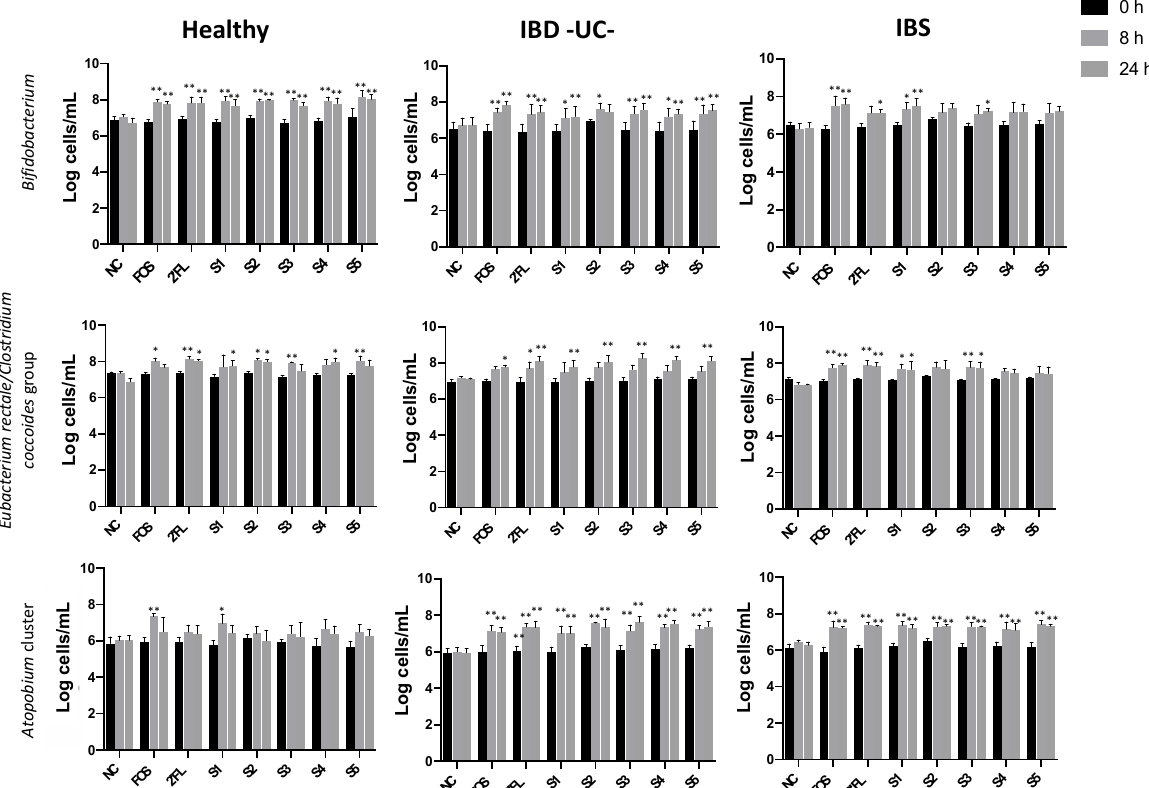
Figure 1. Bifidobacterium , Clostridium coccoides / Eubacterium rectale and Atopobium cluster populations at 0, 8, and 24 h of fermentation with no substrate/negative control (NC); positive control (FOS / inulin mixture); 2 ′ -FL; S1: 2 ′ -FL + L. acidophilus NCFM + B. lactis Bi-07; S2: 2 ′ -FL+ L. acidophilus NCFM + B. lactis Bi-07 + B. lactis Bl-04 + L. paracasei Lpc-37; S3: 2 ′ -FL + L. acidophilus NCFM + B. lactis Bi-07 + L. rhamnosus GG; S4: 2 ′ -FL + L. rhamnosus GG; S5: 2 ′ -FL + L. salivarius UCC118. Error bars show SEM (n = 3). Significant differences from baseline (time 0) are denoted with * ( p ≤ 0.05) or ** ( p ≤ 0.01).